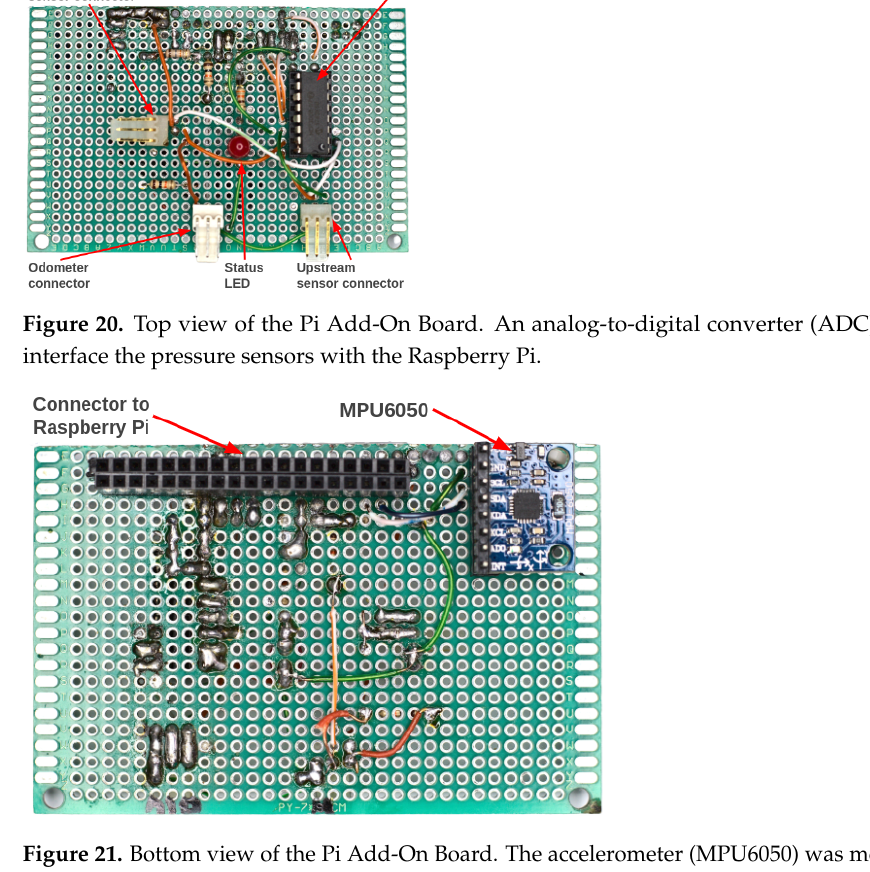
Figure 21. Bottom view of the Pi Add-On Board. The accelerometer (MPU6050) was mounted on the Pi Add-On